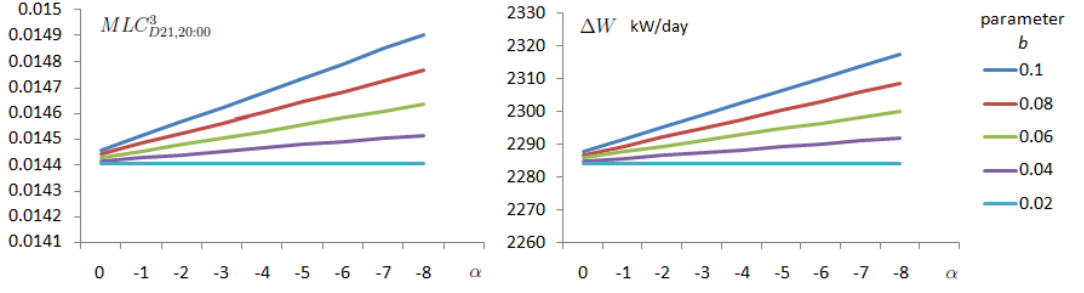
Figure 13. Sensitivity analysis: MLCs and total losses against EV parameters α and b